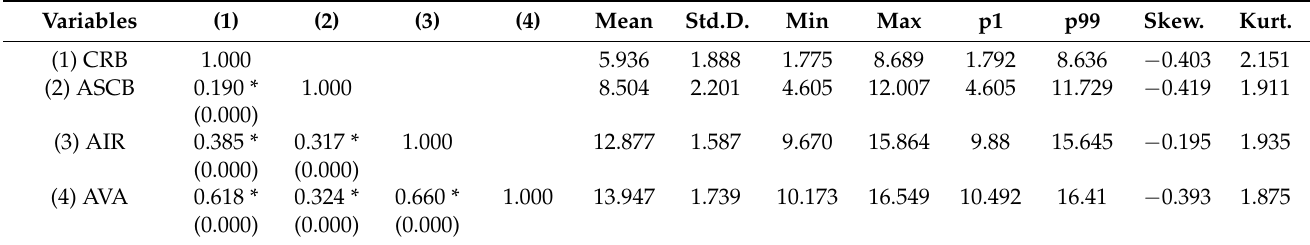
Table 1. Descriptive statistics.